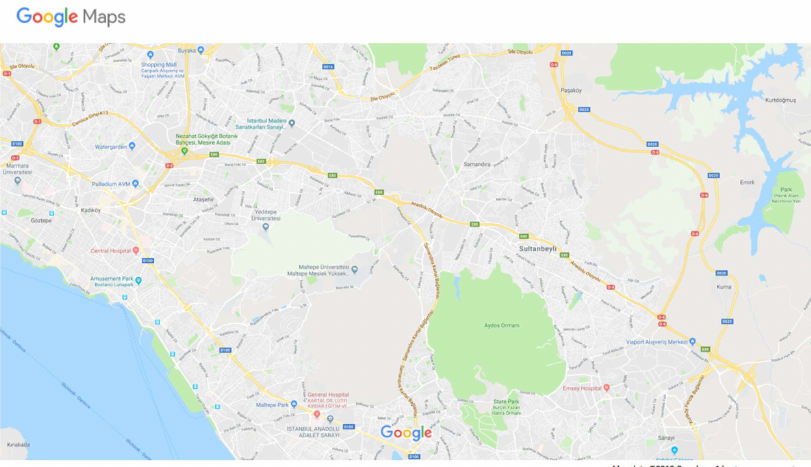
Figure A1. Larger version of Figure 2a.